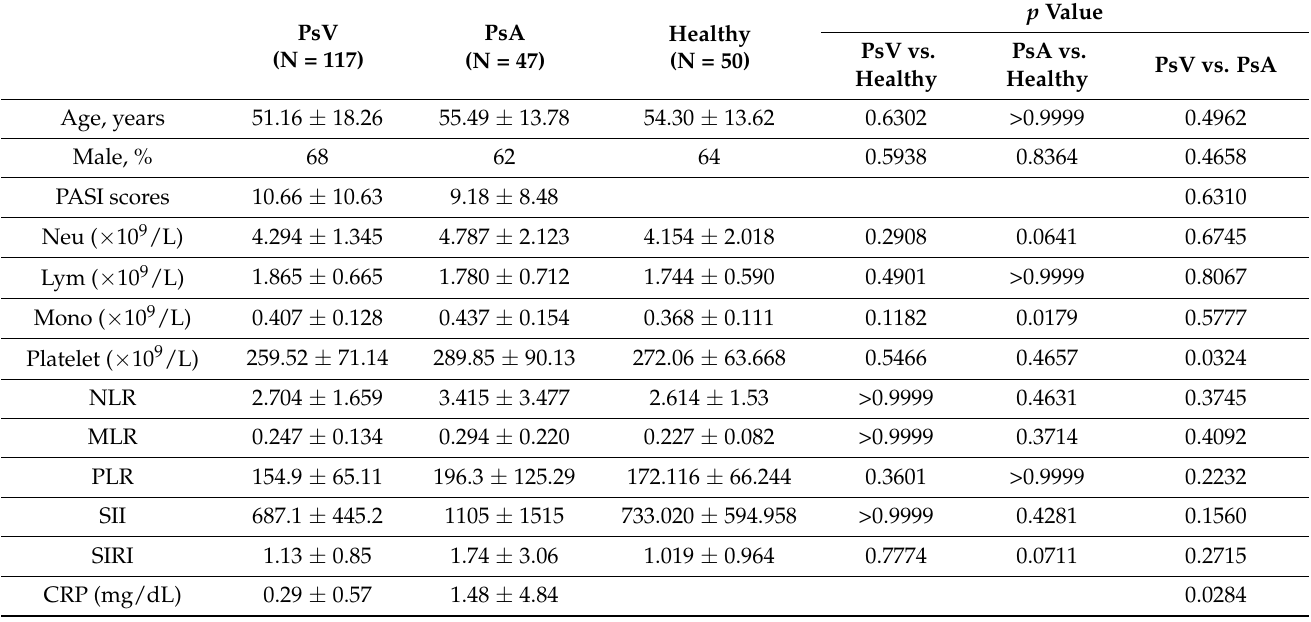
Table 1. Baseline characteristics and inflammatory